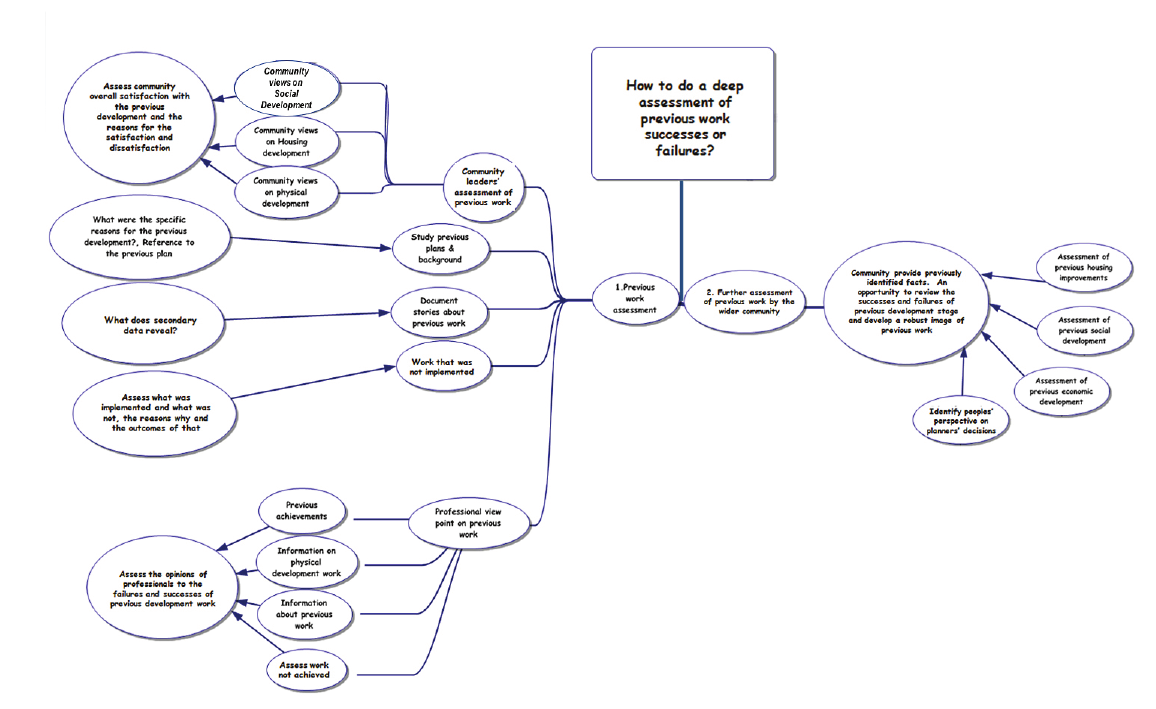
Figure 2. How to conduct an in-depth deep assessment of previous